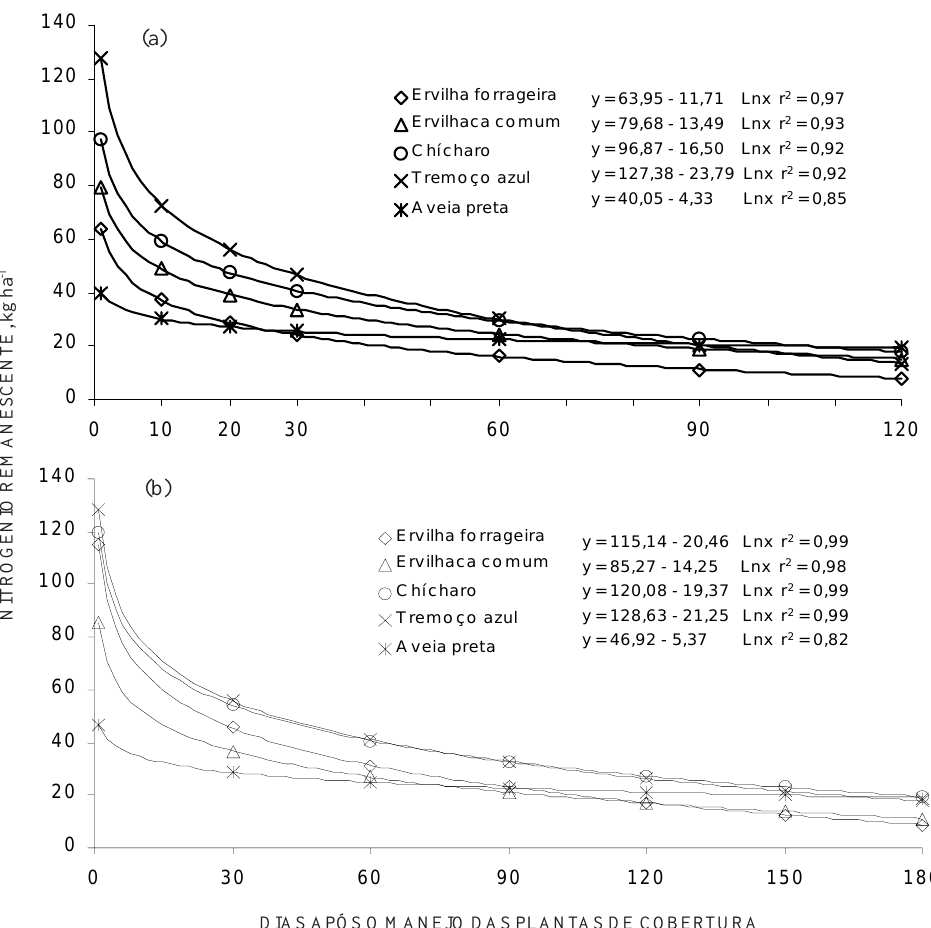
Figura 1. Quantidade de nitrogênio liberado pelos resíduos das espécies de inverno no ano agrícola 1990/91 (a) e 1991/92